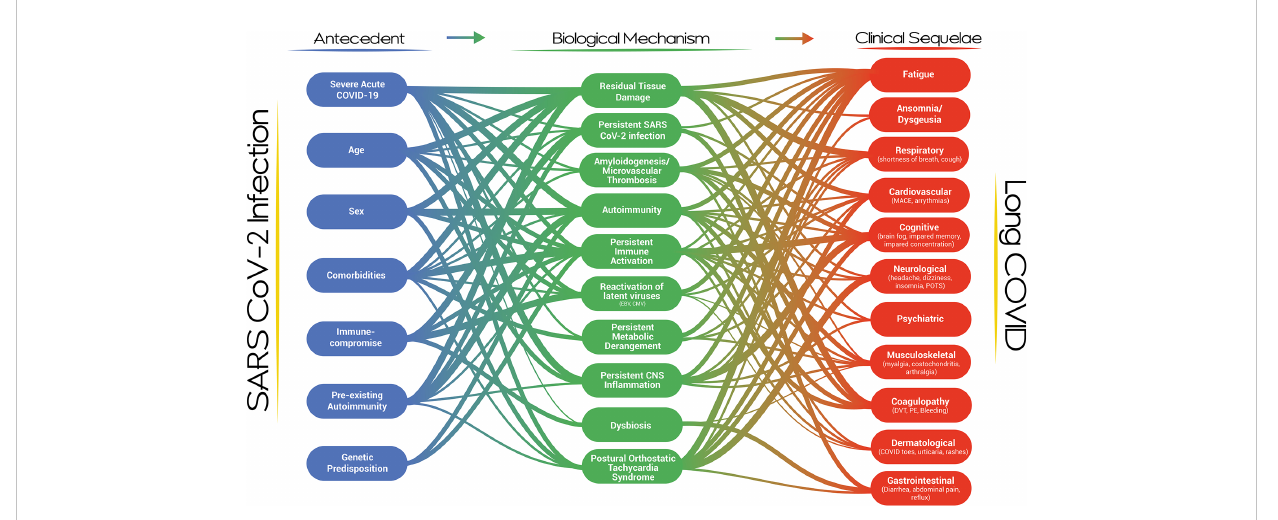
FIGURE 1 A systems-level visualization of the complexity of Long COVID and its